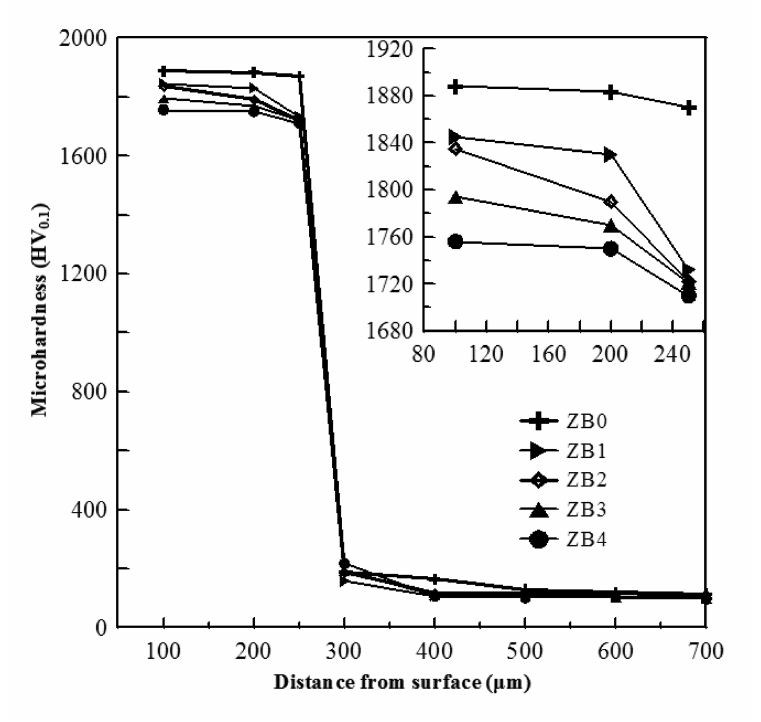
Figure 3: Change in microhardness values from boride surface to substrate for borided pure